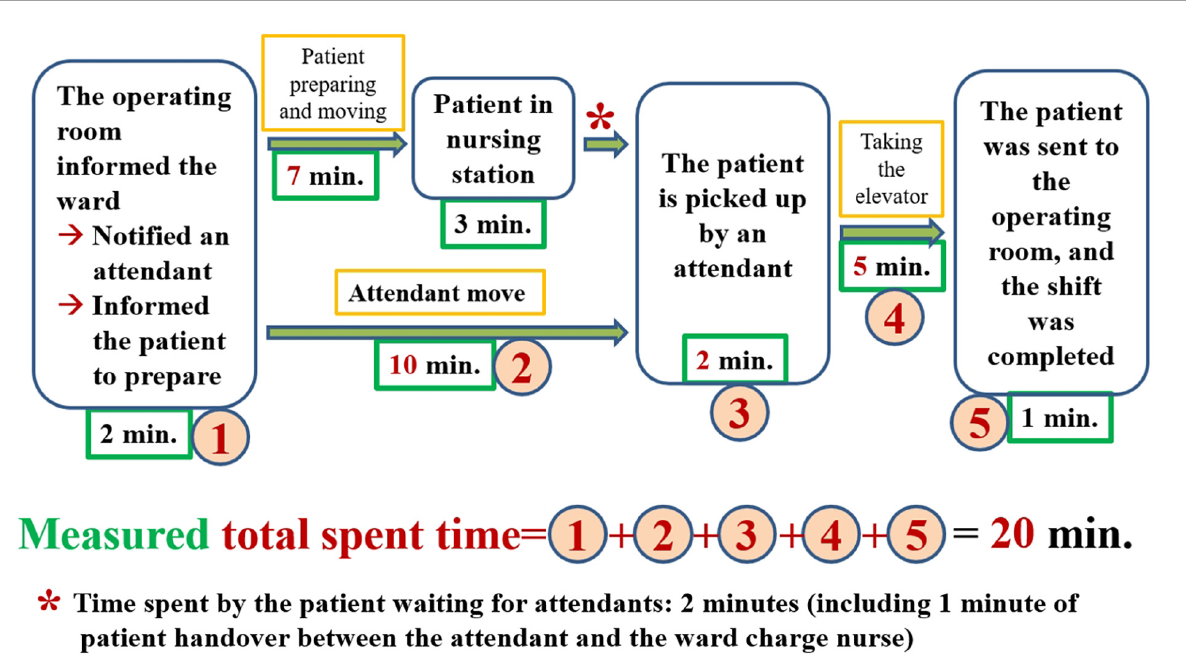
FIGURE7 The value stream map after improvement including time measurements.